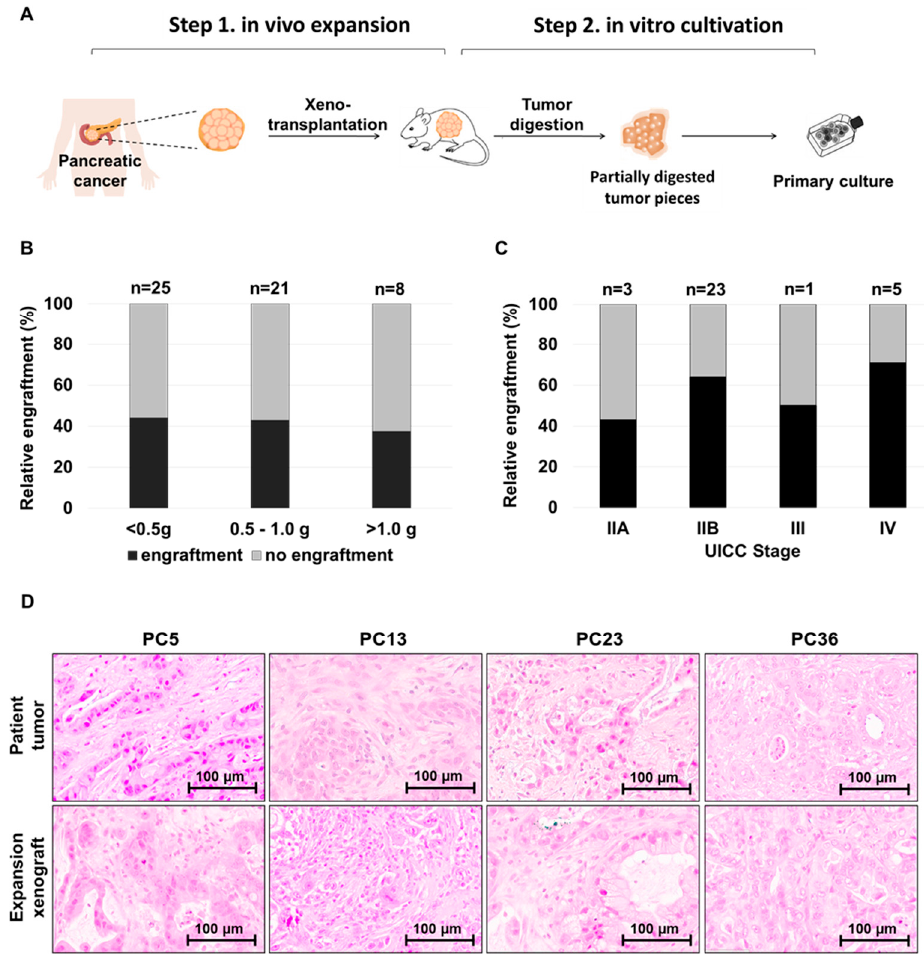
Figure 2. Establishment of primary pancreatic tumor cell cultures following in vivo expansion. ( A ) Surgically resected pancreatic cancer tissue was directly transplanted in NSG mice for in vivo expansion of viable tumor cells (average time to tumor harvest 120 days ± 63 days). Following xenograft formation, tumors were harvested, processed and used for culture establishment and serial re-transplantation. ( B , C ) Engraftment of patient-derived tumor pieces was independent of the weight ( B ) of transplanted tumor and the UICC Stage ( C ) of the matching patient; n = numbers of transplantation cases (each case represents the xenotransplantation of one patient’s tumor). ( D ) Histology of original patients’ tumors is recapitulated by matching expansion xenograft tumors. PC5 and PC 36: Ductal adenocarcinoma; PC13: Adenosquamous carcinoma; PC23: Mucinous ductal adenocarcinoma.